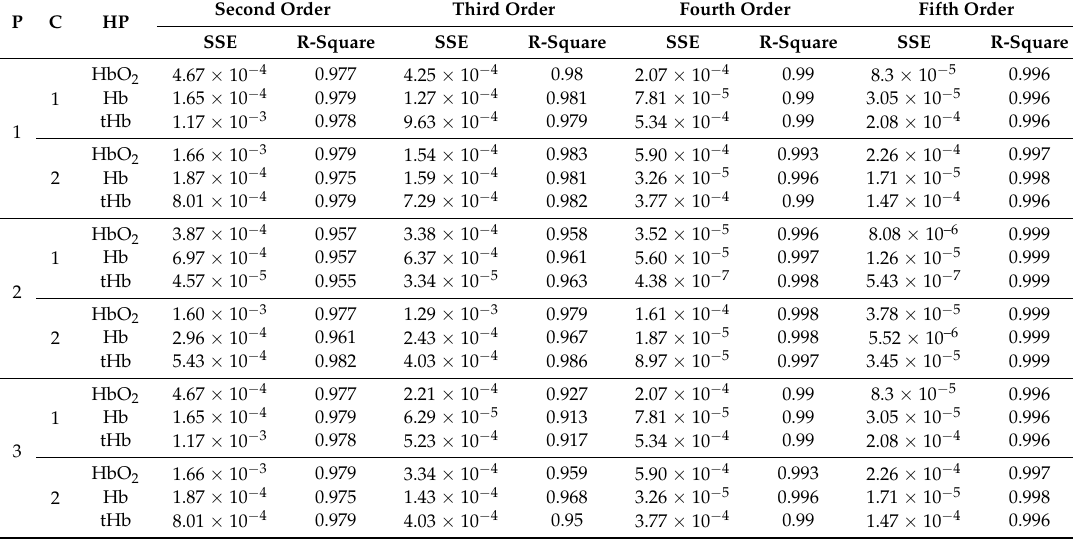
Table 1. Goodness of fit statistics for hemodynamics parameters from the three probes with two different